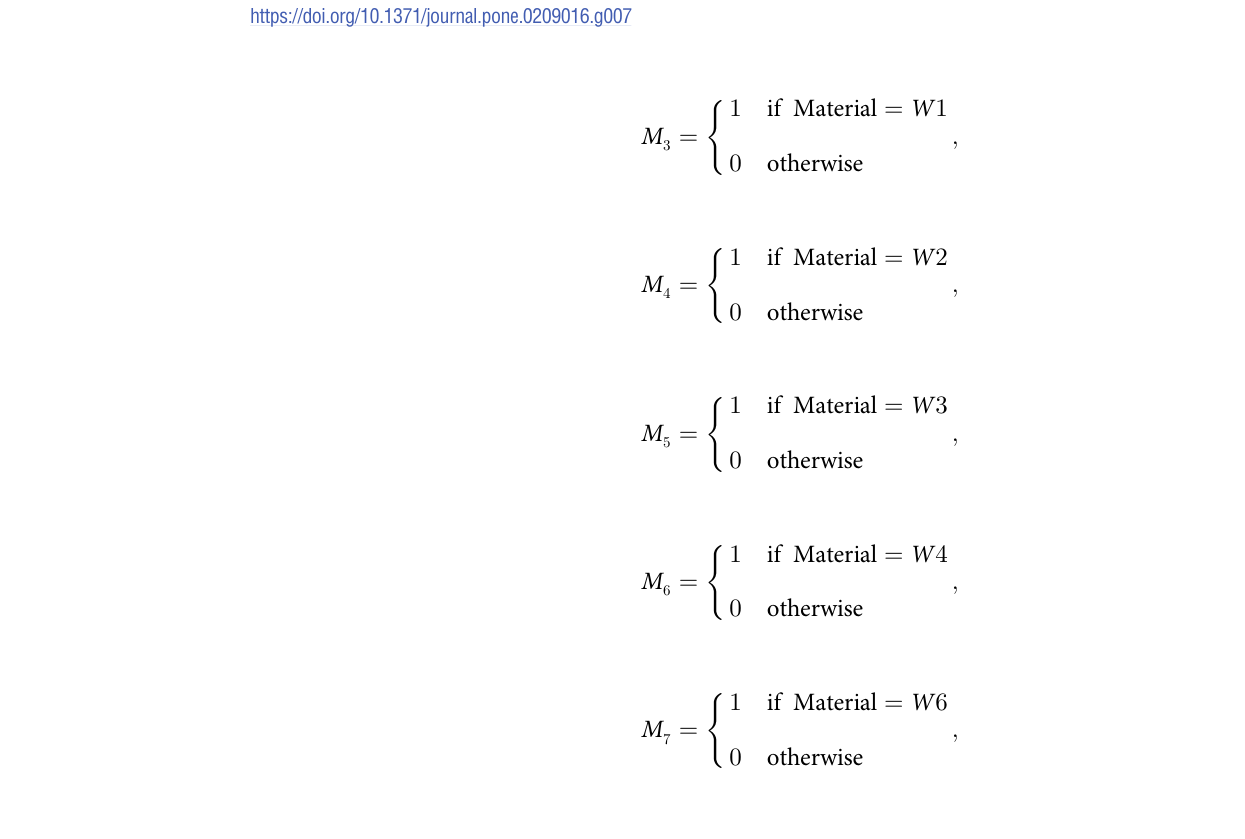
Fig 7. The change in Δ Gloss 60 of clear grades of PET under accelerated exposures with the model curves superimposed on the data. Points represent the measured data and solid and dashed lines represent the models. Vertical, dotted lines represent the location of natural spline